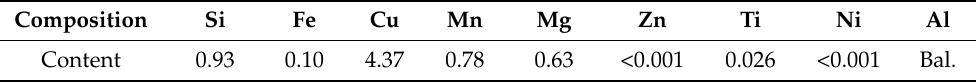
Table 1. The chemical composition percentage of the Al-Cu alloy for the experiment (wt.%).